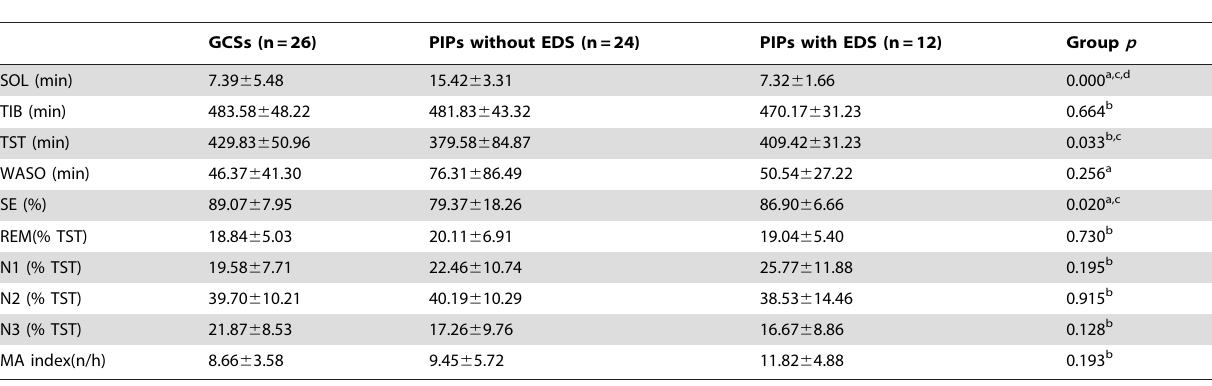
Table 2. PSG sleep data in GSCs, PIPs with EDS and PIPs without EDS (mean 6 SD).